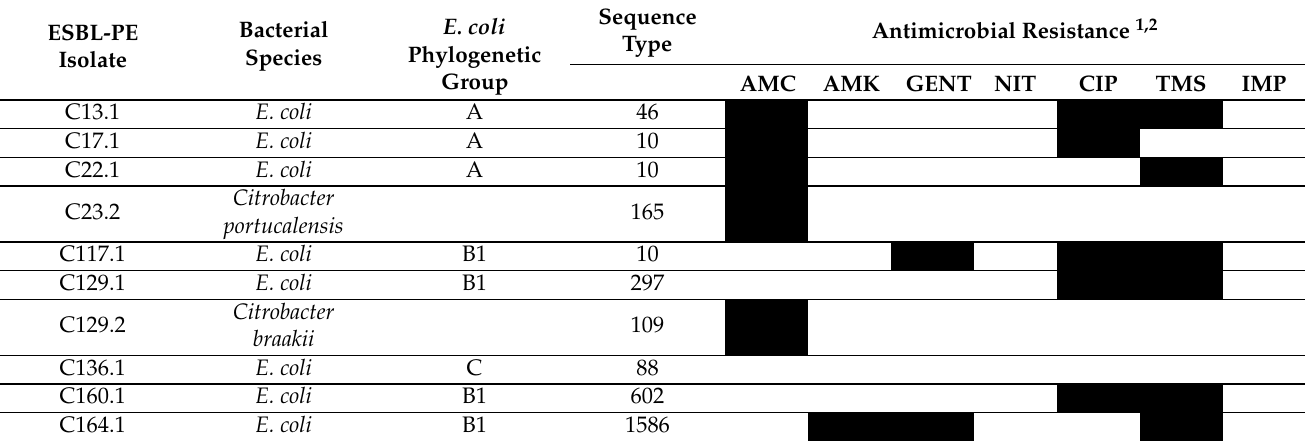
Table 1. The ESBL-PE isolates colonizing healthy community dogs.